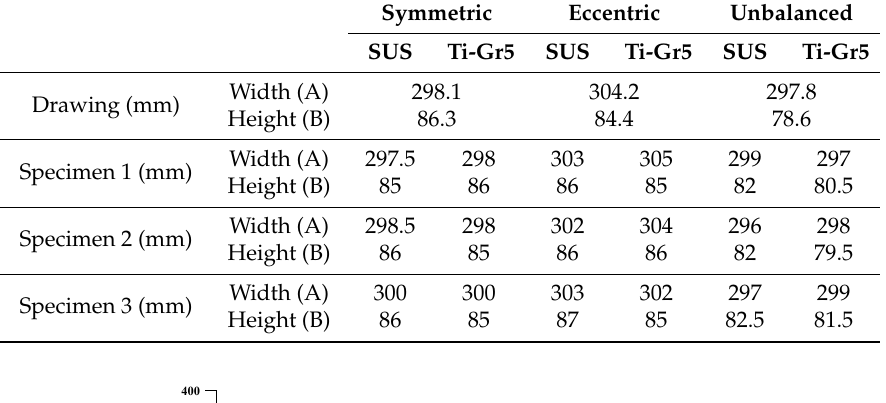
Table 8. Data table for patient-specific Nuss bar dimension accuracy.